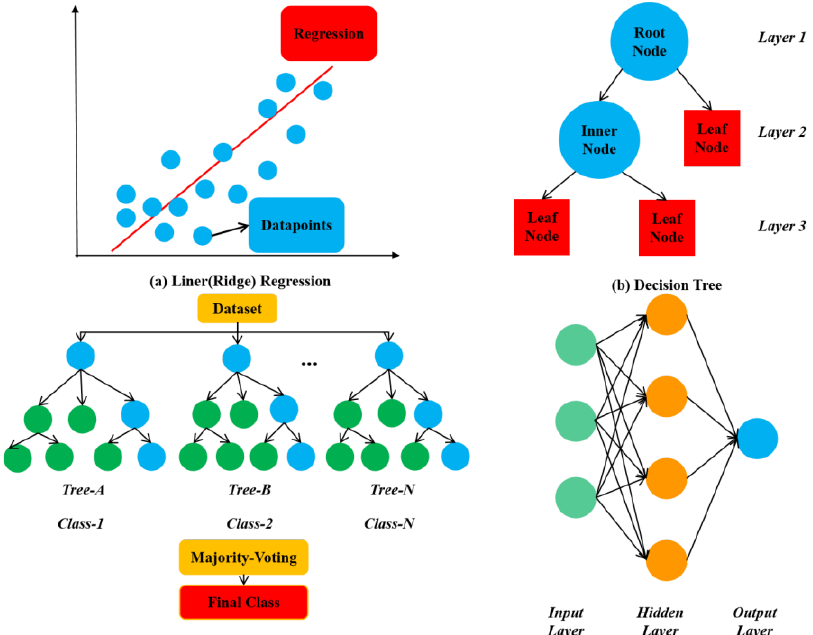
Figure 6. Architecture of the machine learning models.